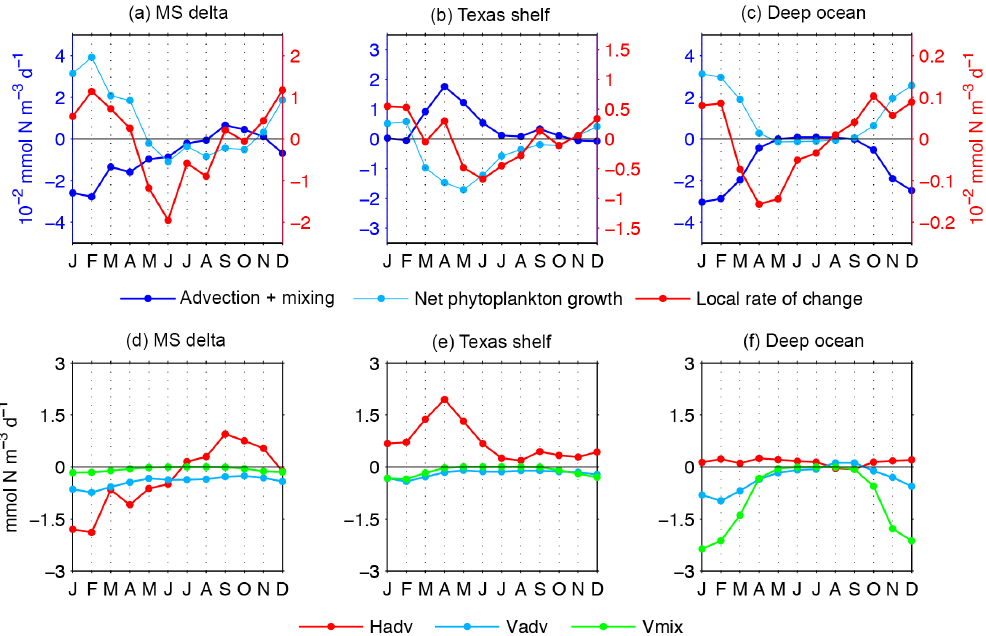
Figure 12. (a–c) Phytoplankton biomass budget: the advection + mixing term represents the sum of advection and turbulent diffusion of phytoplankton biomass, the net phytoplankton growth is production minus biological losses, and the local rate of change is the balance between net phytoplankton growth and the advection + mixing term. Right y axis (red) is for the local rate of change, and left y axis (blue) is for the net phytoplankton growth and the advection + mixing term. (d–f) Components of the advection + mixing term: Hadv, Vadv, and Vmix correspond to horizontal advection, vertical advection, and vertical mixing, respectively. Horizontal mixing can be neglected in the budget analysis, as it is 2 orders of magnitude smaller than other physical term components. Patterns are averages within the upper 30m ocean layer from the Mississippi delta, Texas shelf, and deep ocean (regions depicted in Fig.